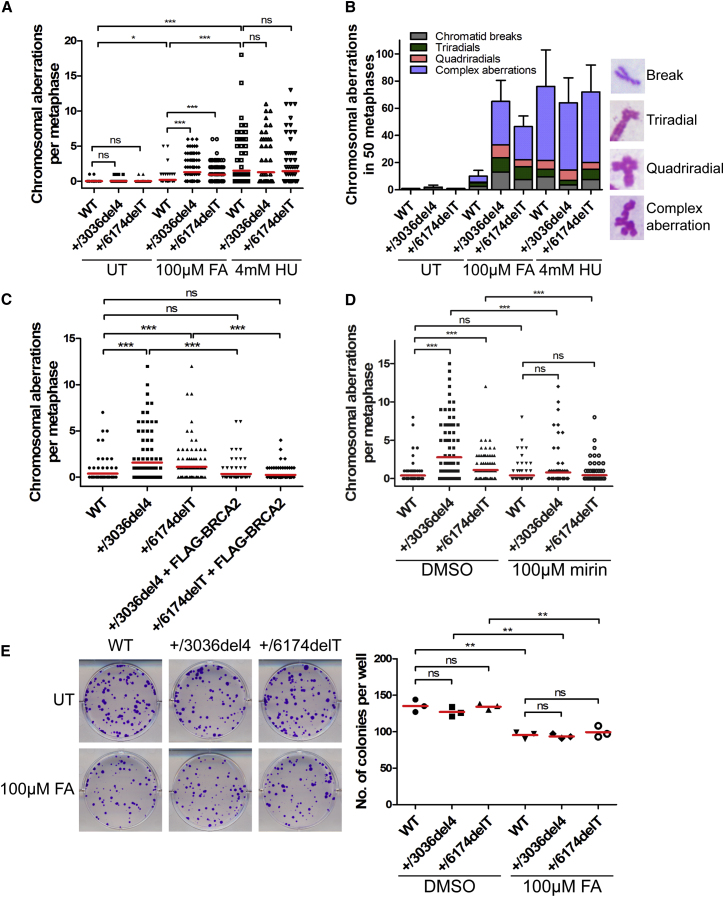
Formaldehyde Triggers Structural Chromosome Aberrations in BRCA2 Heterozygous Cells(A) Frequency of chromosomal aberrations from HeLa Kyoto cells treated as indicated for 5 hr. Red lines indicate the mean, n = 2.(B) A breakdown of the different types of chromosomal aberrations observed in (A). Examples of various chromosomal aberrations are shown.(C) Frequency of chromosomal aberrations in HeLa Kyoto cells treated with 100 μM FA for 5 hr. Red lines indicate the mean, n = 2.(D) Frequency of chromosomal aberrations in HeLa Kyoto cells treated with 100 μM FA for 5 hr in the presence or absence of Mirin. Red lines indicate the mean, n = 2.(E) Representative images of colony formation by HeLa Kyoto cells treated with or without 100 μM FA for 5 hr. Each dot indicates the colony number per well. Red lines indicate the mean. Results represent two independent experiments.See also Figure S6.